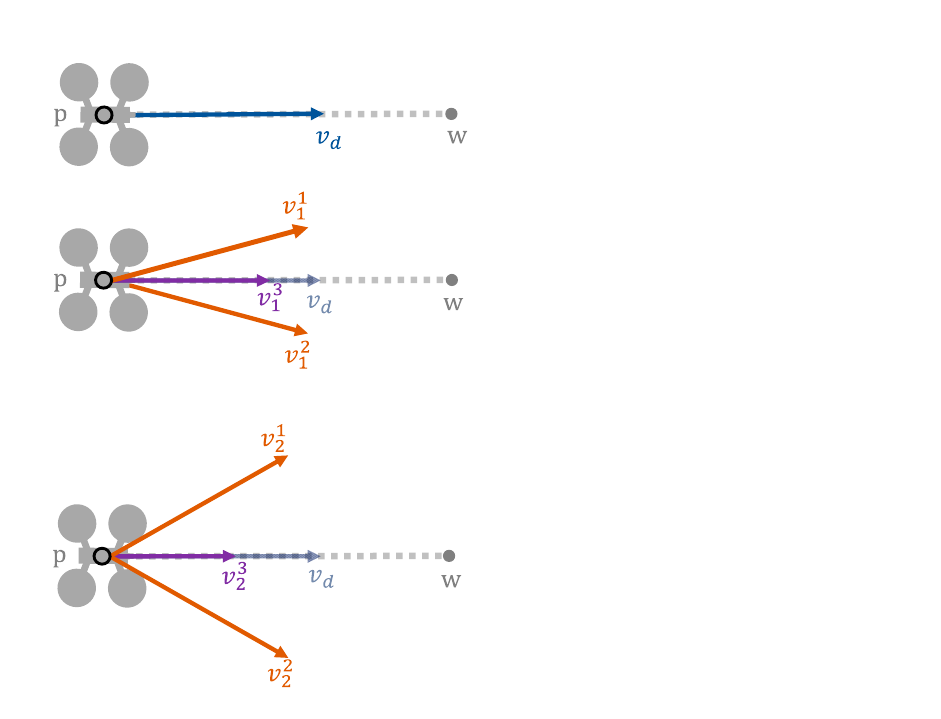
Figure 4. Searching for a valid velocity from the direct one. Above, a UAV with direct velocity ( v d ) flying from the initial position ( p ) to the destination ( w ). In the center, three candidate velocity vectors have been generated in the first iteration. Below, new candidate velocity vectors have been generated, based on those of the previous iteration (if they did not lead to a conflict-free scenario).